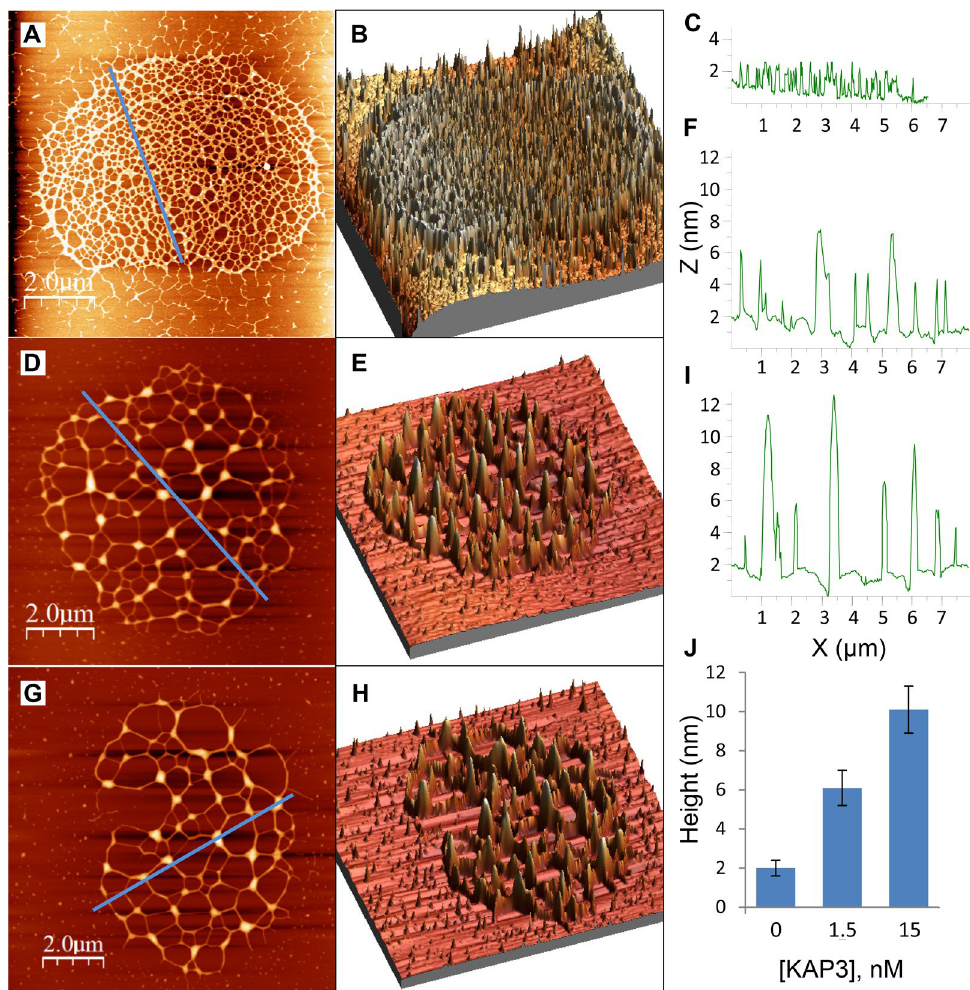
Figure 5. kDNA condensation proceeds via generation of less abundant, larger LCF. (A,D,G) Two-dimensional 2D AFM scan images of uncondensed kDNA (A) and networks that interacted with 1.5 nM (D) and 15 nM (G) of KAP3. In (B,E,H) Three-dimensional 3D- displays of AFM scans, corresponding to those presented in (A,D,G) , respectively. (C,F,I) Height profiles of LCF in the AFM scans presented in (A,D,G) , respectively, corresponding to the paths indicated by the lines crossing the 2D images. Bars = 2 µm. (J) The average heights of LCFs plotted against KAP3 concentrations, as indicated. Three-dimensional 3D-displays of AFM scans were based on the total data collected in the scan. Height profiles in AFM scans, were based on measurements corresponding to the random paths, indicated by the lines crossing the images. Networks analyzed: uncondensed kDNA networks (n = 22), partially condensed networks in the presence of 1.5 nM (n = 17) and 15 nM KAP3 (n =